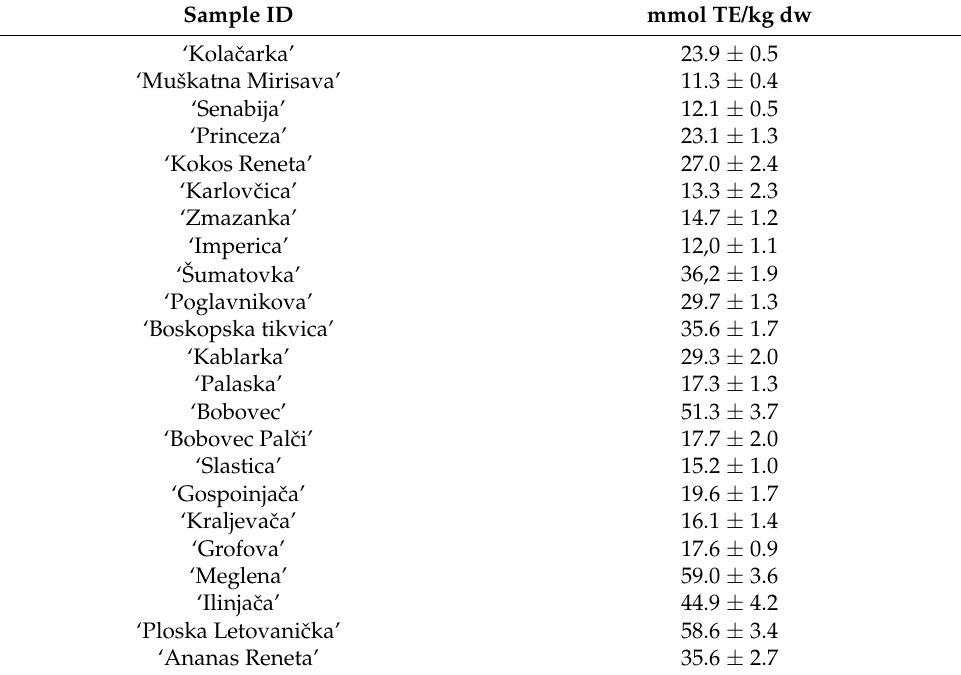
Table 3. Antioxidant activity (mmol TE/kg dw) of traditional apple